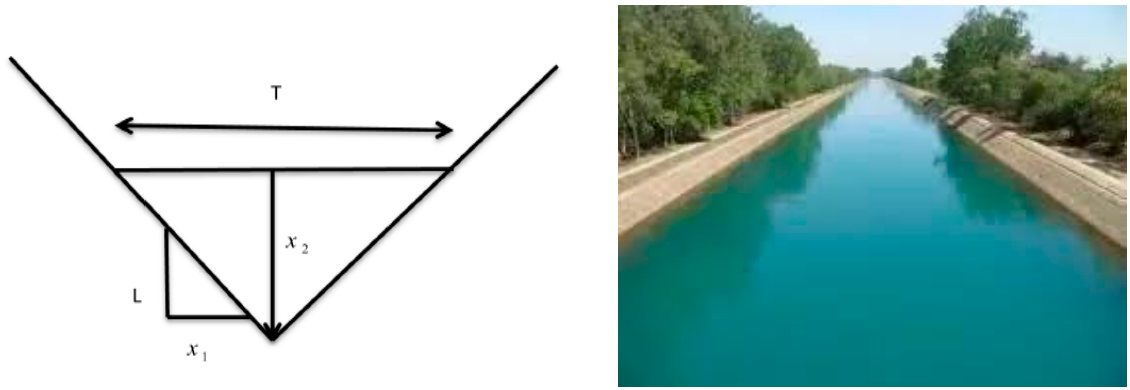
Figure 4. Triangular canal section.